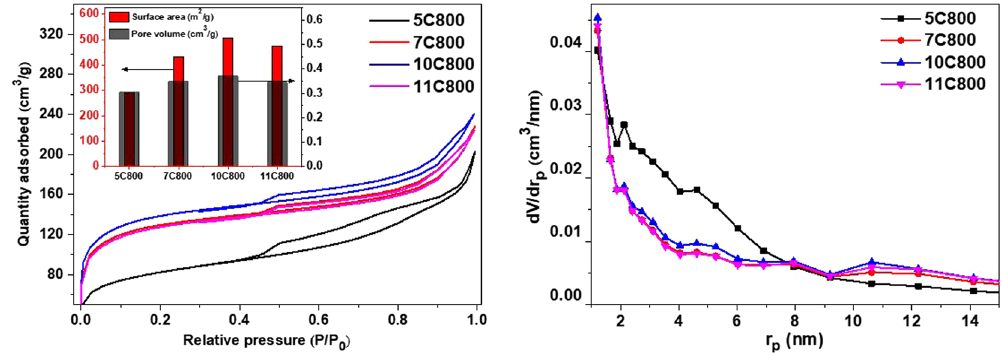
Figure 5. BET analysis of all the samples synthesized at 800